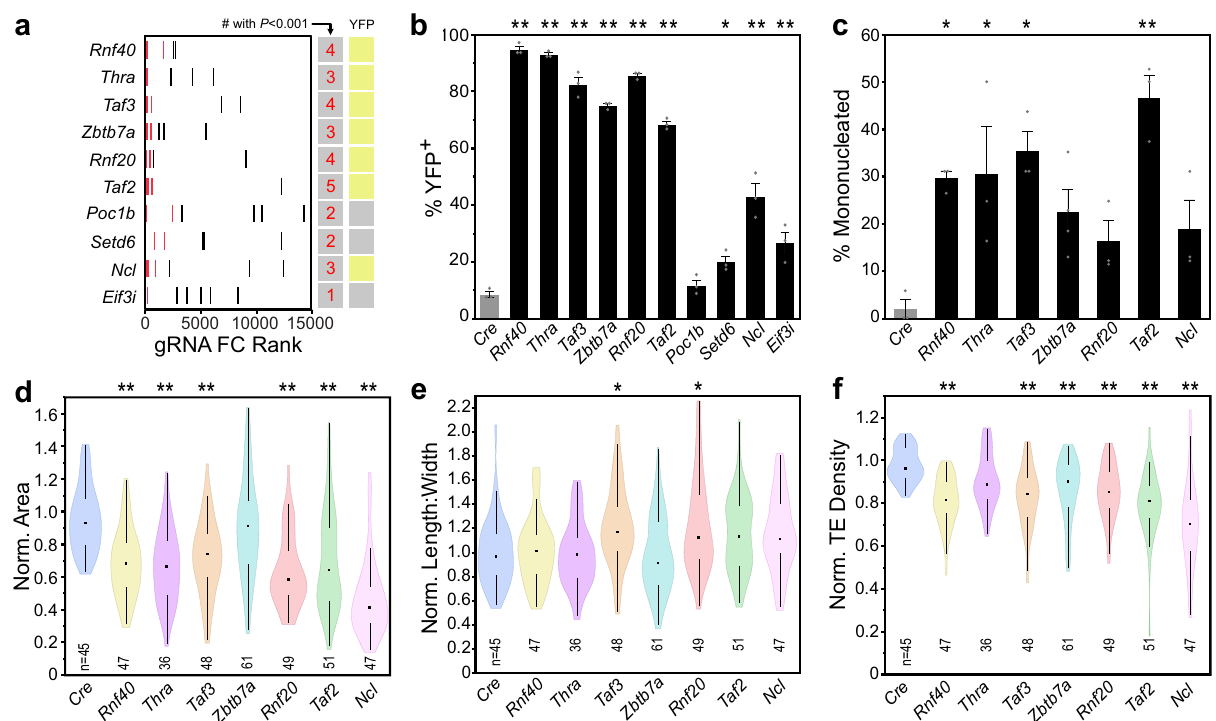
Fig. 2 Validation of top candidates from the forward genetic screen. a Top ten candidates ranked by MAGeCK enrichment score (lower rank indicates greater enrichment). The six guides for each candidate are ranked by individual enrichment. Enriched gRNAs with Benjamini – Hochberg corrected Wald test P < 0.001 are colored in red and summed in the fi rst column. Candidates were tested by treating R26 Cas9-GFP ; Myh7 YFP neonatal pups with the most highly ranked individual gRNA. AAV-Cre without gRNA served as negative control. Presence (column 2, yellow box) or absence (gray box) of persistent YFP expression at four weeks was assessed by imaging fi xed, dissociated CMs. b Quanti fi cation of Myh7 YFP activation within transduced (GFP + ) CMs by fl ow cytometery. AAV-Cre was used as negative control. n = 3. P for all genes, except Poc1b and Setd6, was <0.0001. Setd6 P = 0.0111. c Quanti fi cation of mononucleation among dissociated, GFP + control CMs or YFP + candidate-depleted CMs. n = 3. Signi fi cant P : Rnf40, 0.0128; Thra, 0.0102; Taf3, 0.0027; Taf2, 0.0001. Error bars denote standard error. d – f Normalized projected area ( d ) and length:width ratio ( e ) of control and candidate-depleted CMs. Measurements from dissociated YFP + CMs were normalized to YFP- cells from the same heart. Signi fi cant P , area: Rnf40, Thra, Taf3, Rnf20, Taf2, and Ncl <0.0001. Signi fi cant P , length-to-width: Taf3, 0.007; Rnf20, 0.0042. f T-tubule transverse element density for control and candidate-depleted CMs as measured by AutoTT software-based quanti fi cation of CAV3 immunostaining. Signi fi cant P : Rnf40, Taf3, Rnf20, Taf2, Ncl < 0.0001; Zbtb7a, 0.0003. Bar plots show mean ± SD. At least 69 CMs from three mice were measured per group. Violin plots: shape indicates data distribution; point, median; whiskers, starts at quartile and extends 1.5 times the interquartile distance. Dunnett ’ s two-tailed t -test vs. Cre control: * P < 0.05, ** P < 0.001. Source data are provided as a Source Data fi